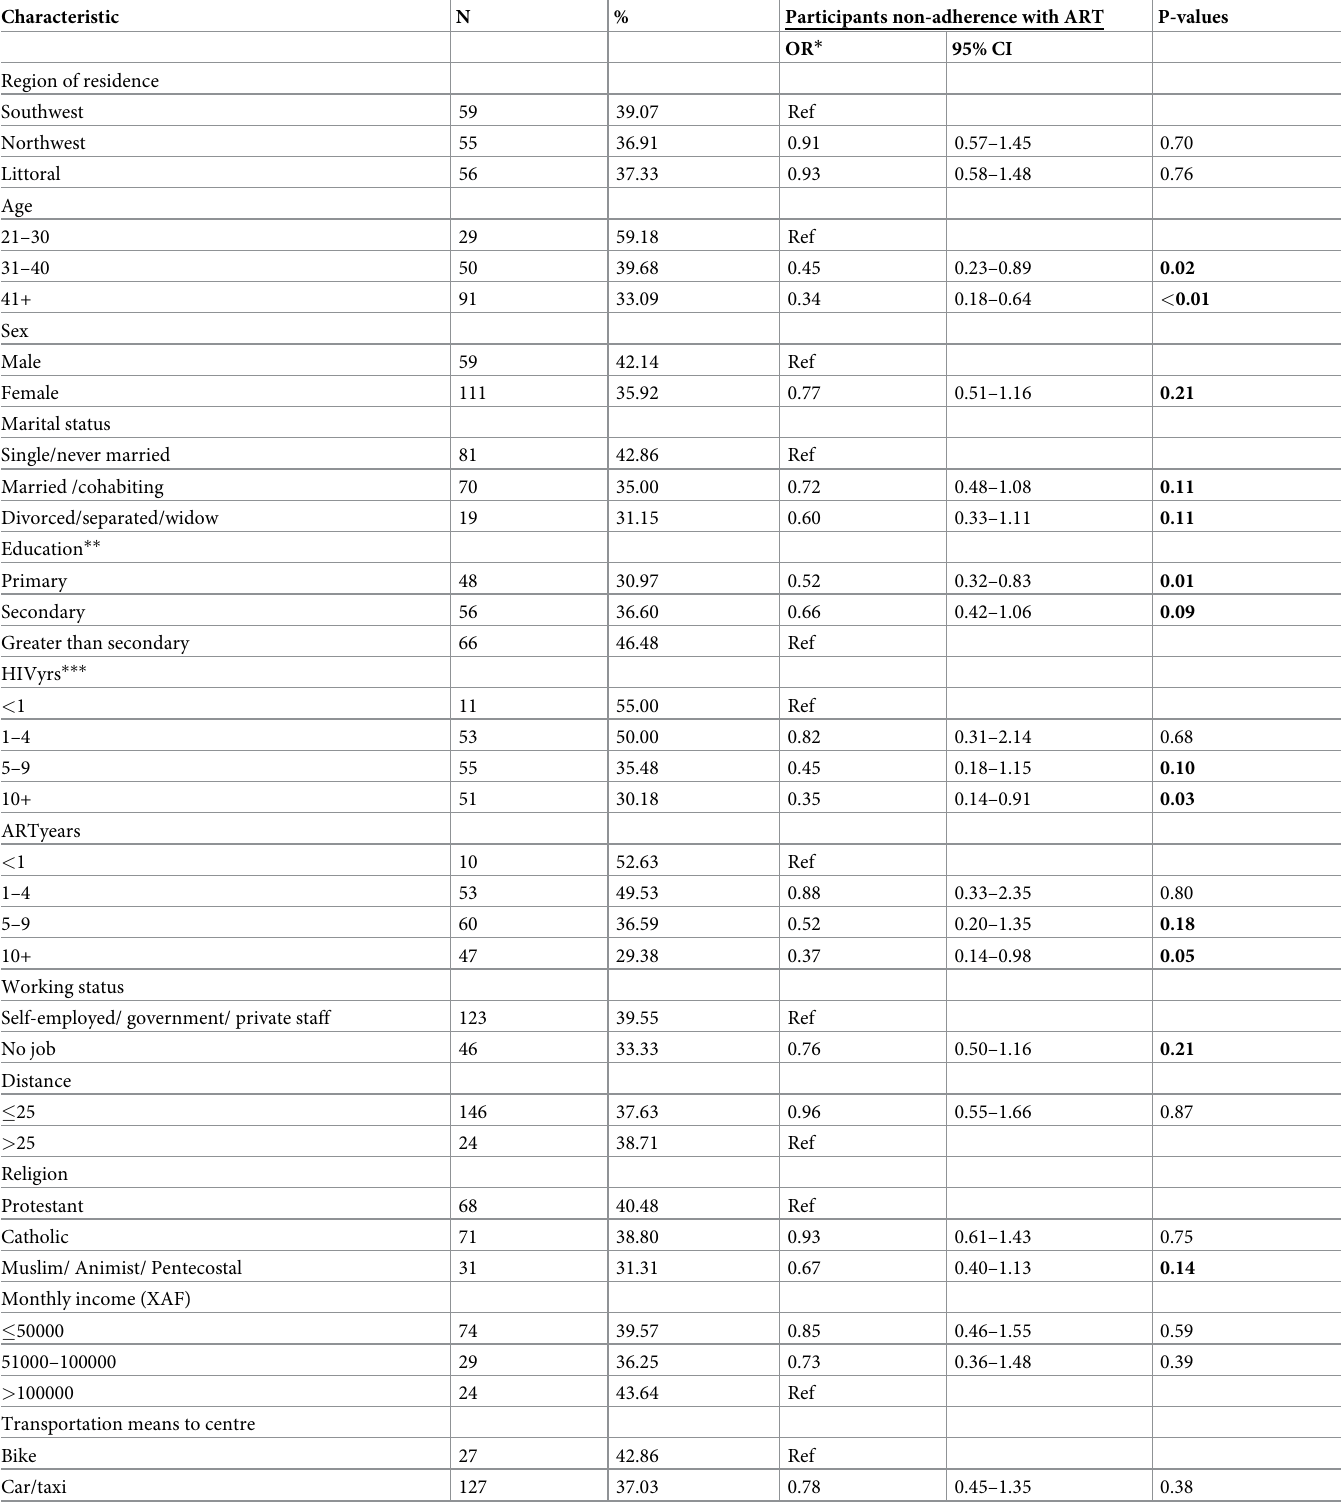
Table 4. Correlates of participants non-adherence with ART- bivariable